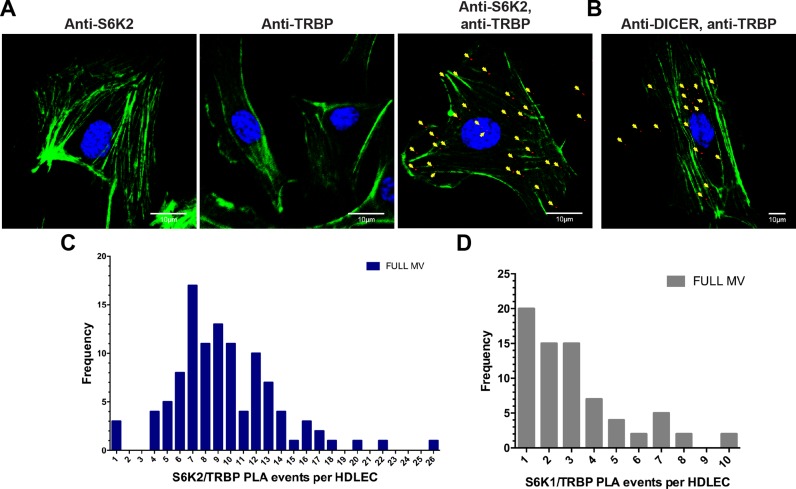
Endogenous TRBP interacts with S6Ks in primary HDLEC. (A) Analysis of TRBP and S6K2 interaction by PLA (red) in HDLECs growing in full growth factor media. Nuclei (blue) and F-actin (green) staining are also shown (scale bar: 10 μm). PLA events (in red) are indicated with yellow arrows. (B) Analysis of TRBP and DICER interaction by PLA (red) in HDLECs growing in full growth factor media. PLA events (in red) are indicated with yellow arrows. (C) Histogram of TRBP/S6K2 PLA events per cell detected in HDLECs cultured in full growth factor media. (D) Histogram of TRBP/S6K1 PLA events per cell detected in HDLECs cultured in full growth factor media.